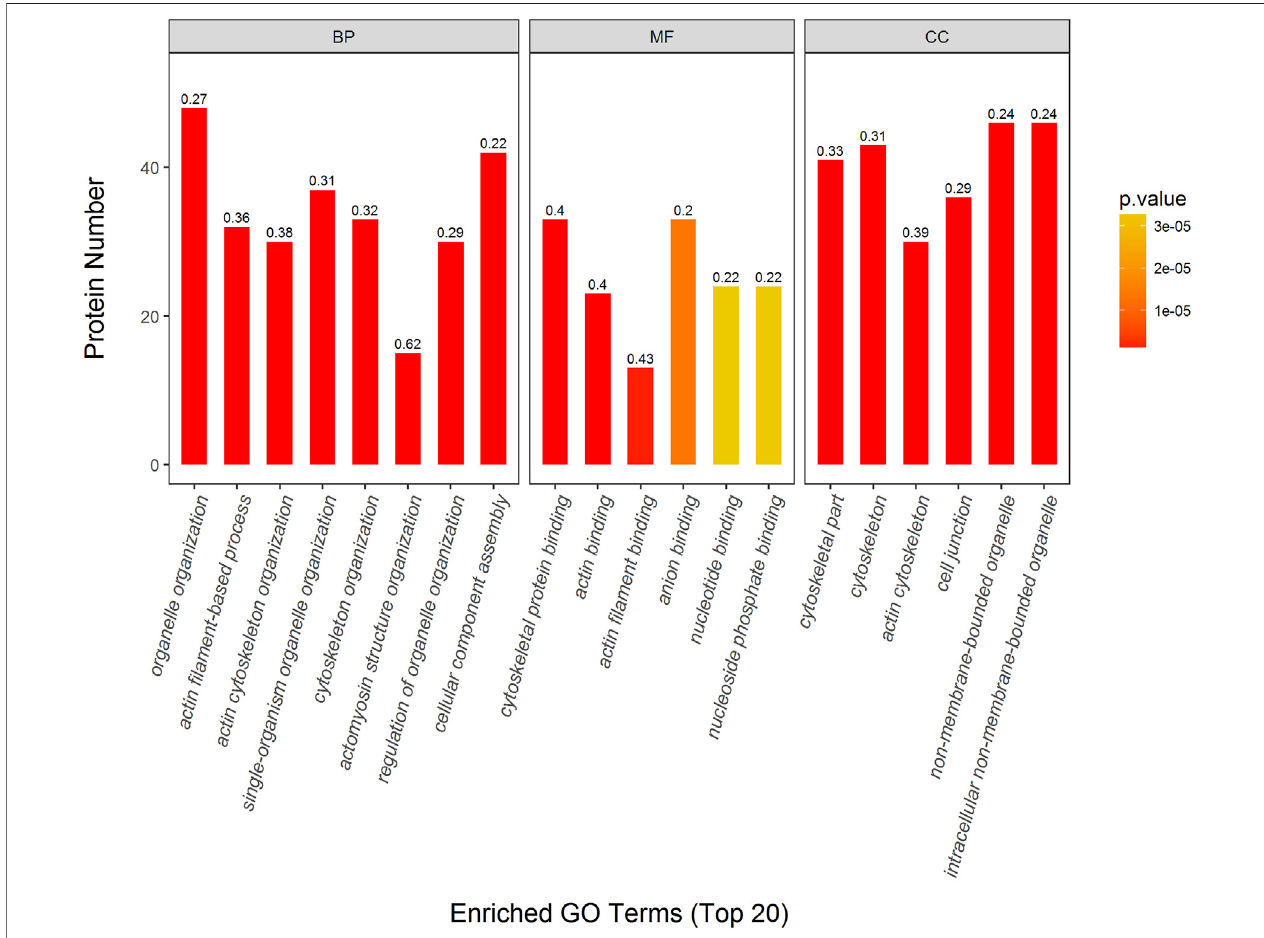
FIGURE5| Top20enrichedGOtermsofsigni fi cantlydifferentiallyexpressedproteins(DEPs)inSMI:Mod. p value(morelowermoreintenseinredcolor)represents the enriched degree. Each number above the bar charts is the richFactor (richFactor ≤ 1), which is the ratio of the number of proteins that have been annotated in this